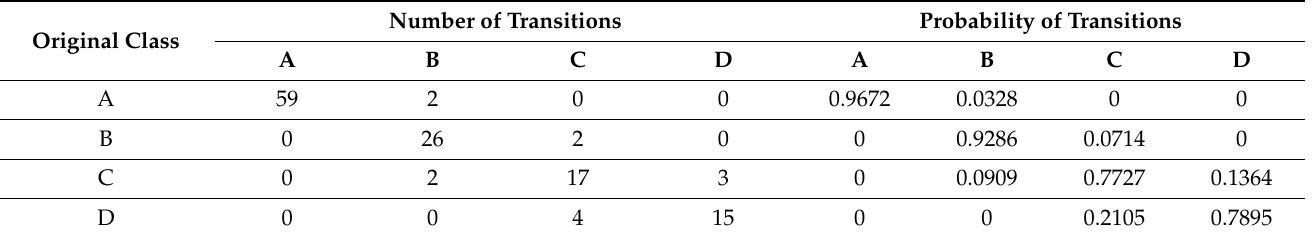
Table 1. The transition matrix for the evolution of urban size, measured with urban area, in YREB during 2012–2019.